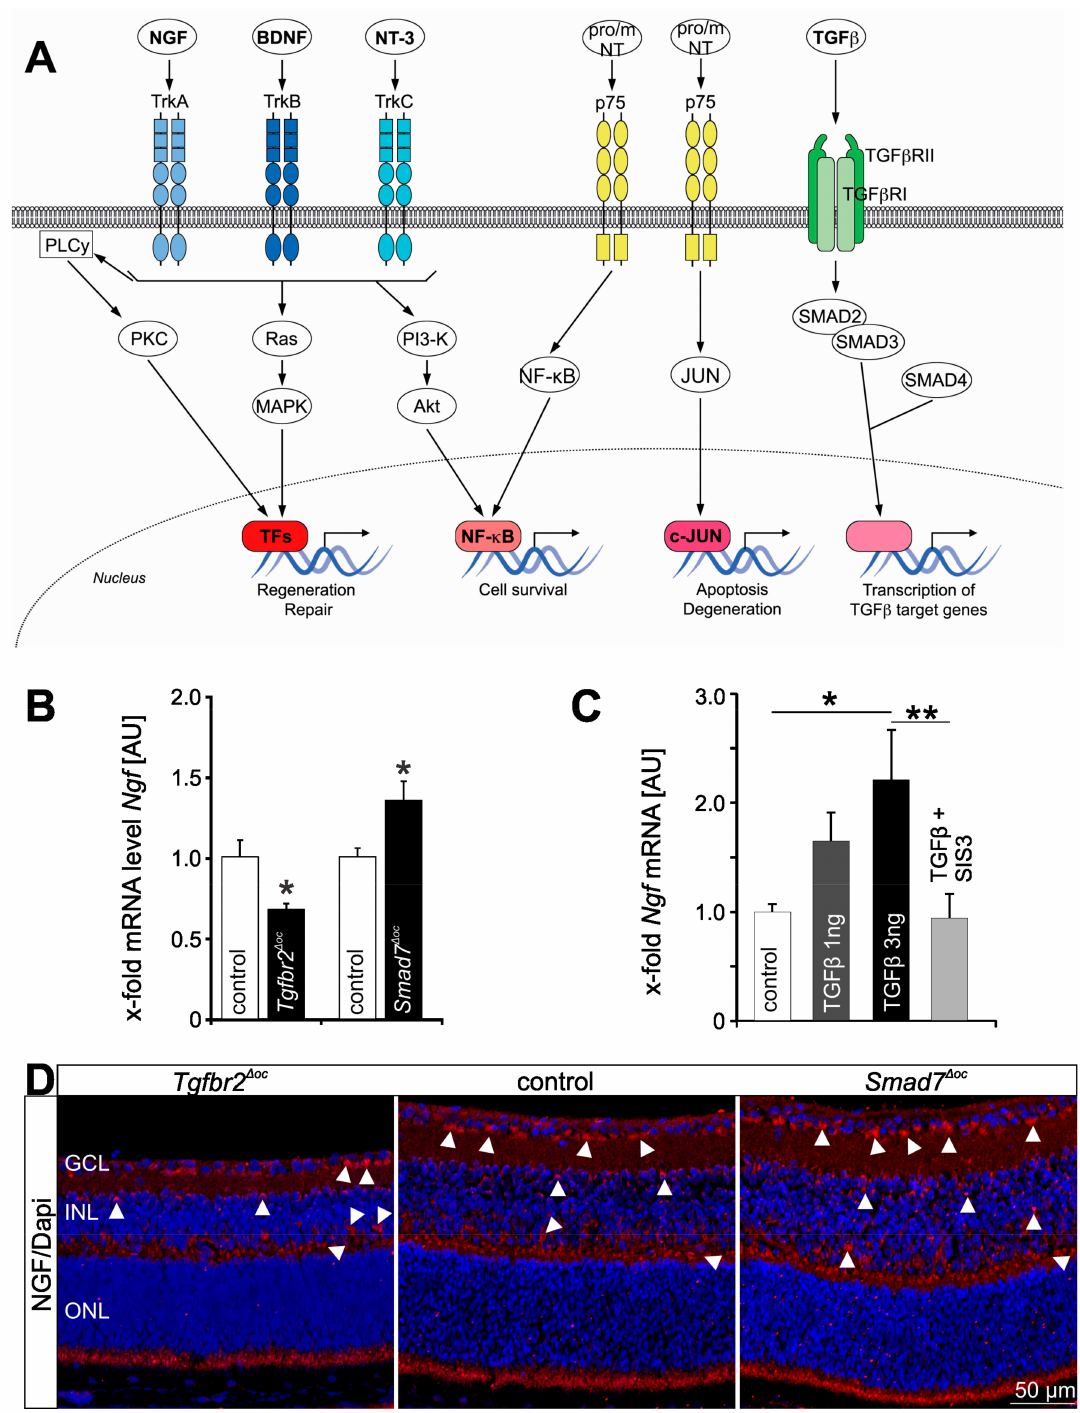
Figure 1. Neurotrophin and TGF β signaling. ( A ) Simplified scheme showing neurotrophin and Smad-dependent TGF β signaling pathways. ( B ) Quantitative real time RT-PCR (qPCR) of Ngf mRNA expression in Tgfbr2 ∆ oc and Smad7 ∆ oc -deficient and in their respective control littermate’s retinae. Data are mean ± SEM, n ≥ 5, * p = 0.0214 ( Tgfbr2 ∆ oc ), * p = 0.0366 ( Smad7 ∆ oc ). Expression is normalized to Gapdh. ( C ) QPCR analyses of RNA samples from neuronal cells (RGC-5 cells) treated with TGF β 2 (1 and 3 ng) or in combination with SIS3 (1 µ M + 3 ng TGF β 2), an inhibitor of Smad3 phosphorylation. Ngf mRNA expression significantly increases following TGF β treatment and its expression reverses to control levels if TGF β is inhibited. Data are mean ± SEM, n ≥ 4, * p = 0.0119 (3 ng TGF β 2), ** p = 0.0059 (SIS3 + TGF β 2). Expression is normalized to Gapdh . ( D ) NGF immunoreactivity (red) in the retinae of Tgfbr2 ∆ oc , control and Smad7 ∆ oc -deficient mice at postnatal day 10. Nuclei are DAPI stained (blue). In the retina of the Smad7 ∆ oc -deficient mouse, NGF immunoreactivity